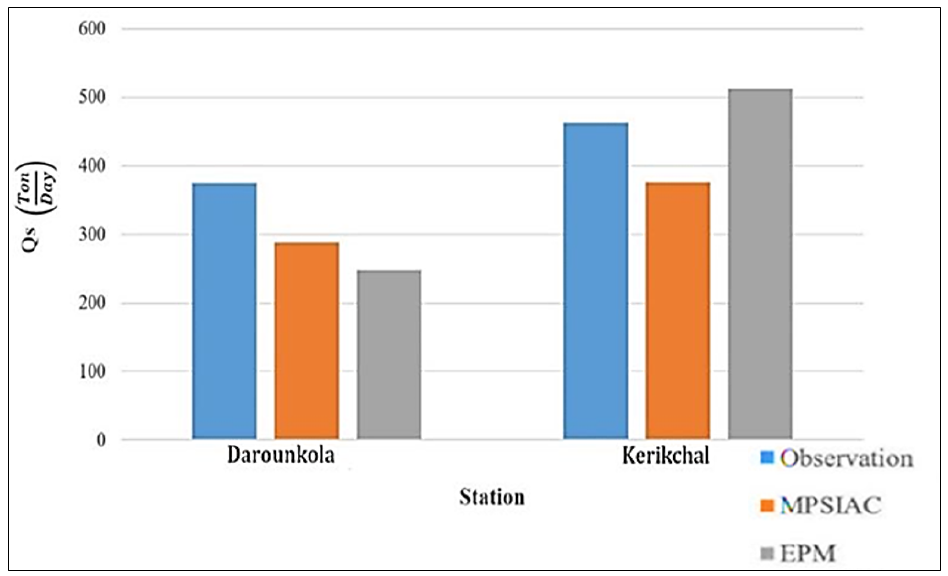
Figure 10. Comparison between the results predicted by both MPSIAC and EPM models to those of field measurement at Darounkola and Kerikchal